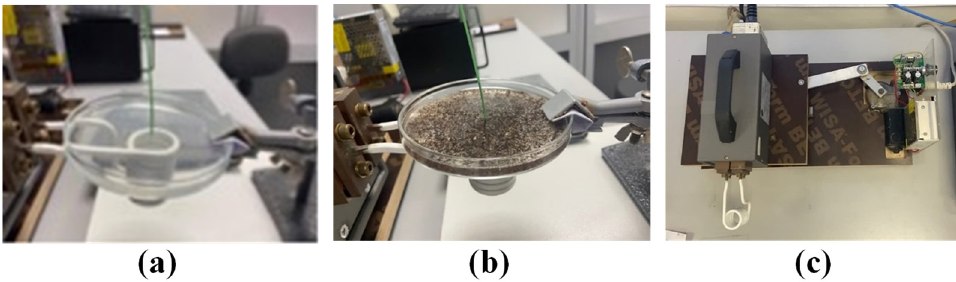
Figure 1. Experimental setup for measuring temperature rise in HTP ( a ), CTP ( b ), and Coil drive mechanism ( c ).